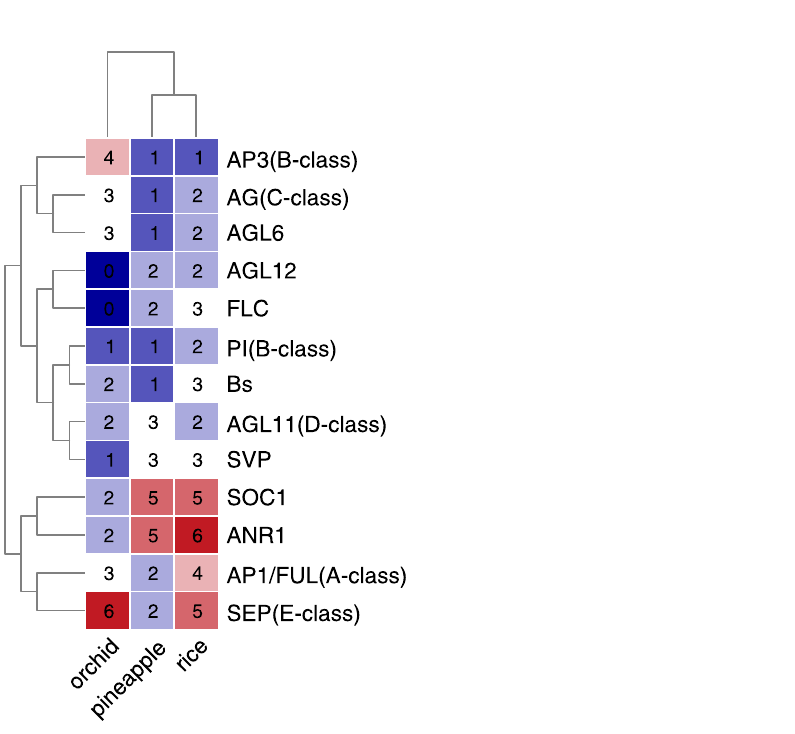
Figure 5. Heat map of the number of MIKC genes from different clades in rice, pineapple, and